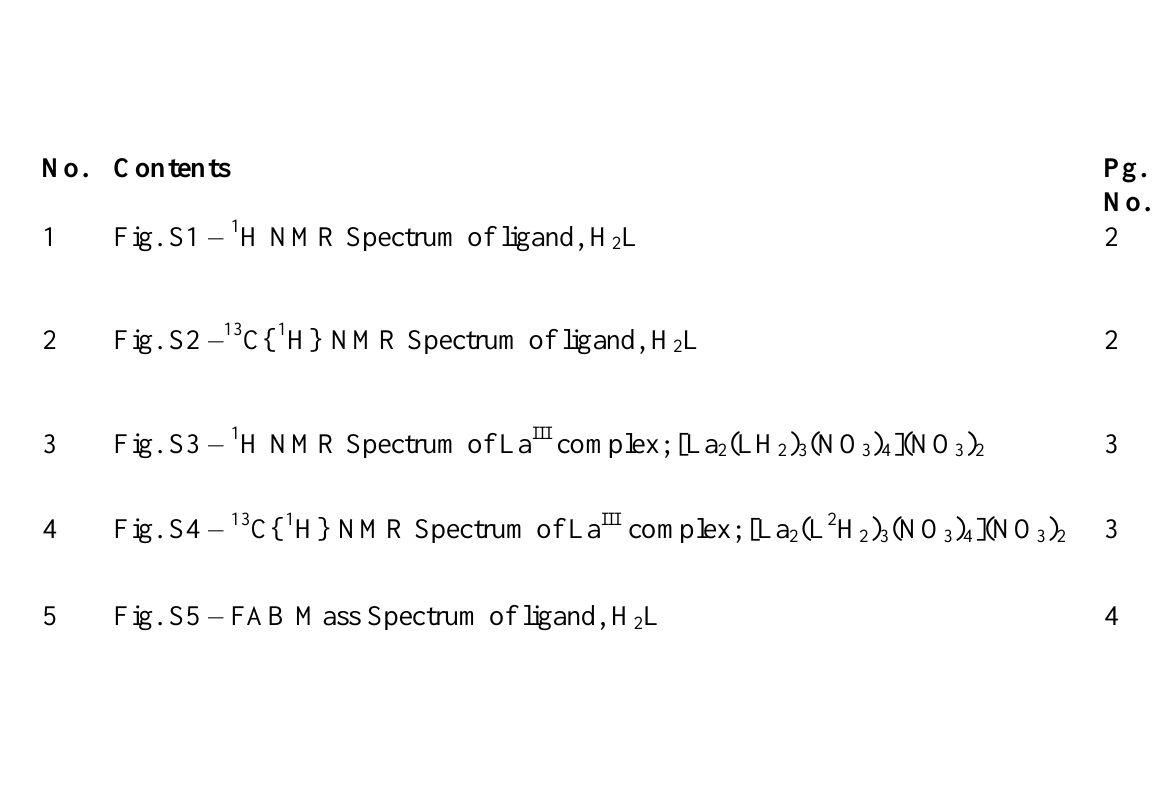
Fig. S1 – 1 H NMR Spectrum of ligand, H Fig. S2 – 13 C{ 1 H} NMR Spectrum of ligand, H Fig. S3 – 1 H NMR Spectrum of La III complex; [La Fig. S4 – 13 C{ 1 H} NMR Spectrum of La III complex; [La Fig. S5 – FAB Mass Spectrum of ligand, H